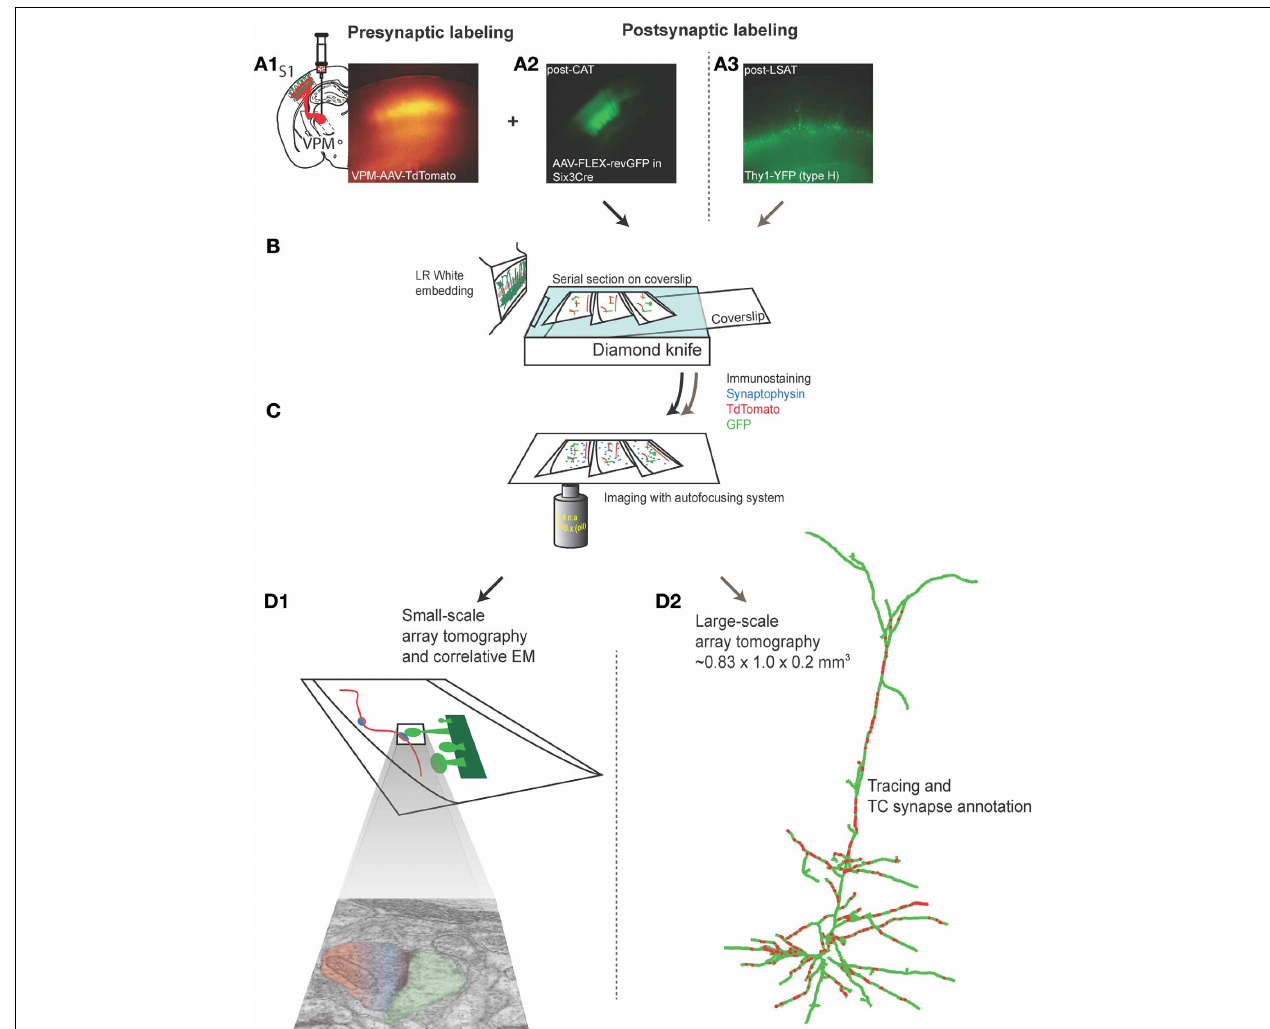
FIGURE 1 | Labeling and imaging thalamocortical synapses on L4 or L5 barrel cortex neurons using array tomography and electron microscopy. (A1) Low power fluorescence photomicrograph of tdTomato-expressing TC axons and terminals in a fixed section of barrel cortex prepared from an 5–6 month old mouse in which AAV-tdTomato was stereotaxically injected in VPm 20–30 days earlier (inset left shows schematic of VPm injection). (A2) Low power fluorescence photomicrograph of GFP fluorescence in neurons in L4 barrel cortex in a fixed section from adult six3-CRE mouse in which AAV-FLEX-revGFP virus was injected into L4, 20-30 days earlier. (A3) Low